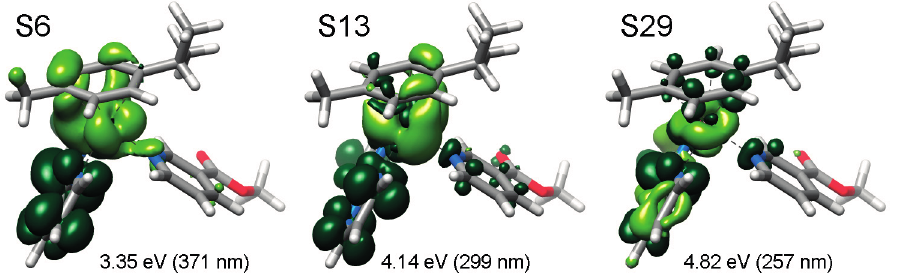
Figure 6. Selected electron density difference maps (EDDMs) of singlet excited state transitions of 1 in water (B3LYP/LANL2DZ/6-31G** level, PCM method). Light green indicates a decrease in electron density, while green indicates an